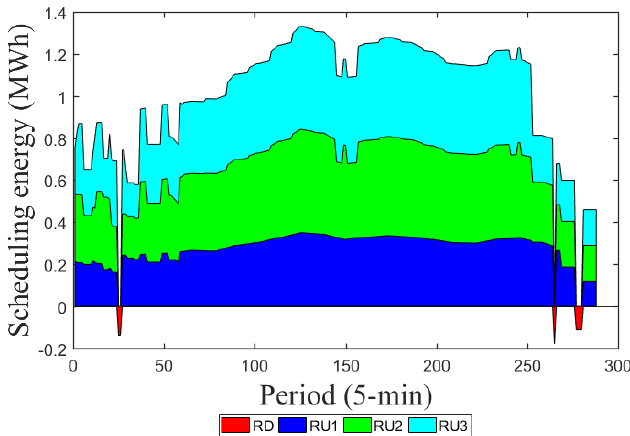
Figure 7. Reserve services used to balance the system in real-time.